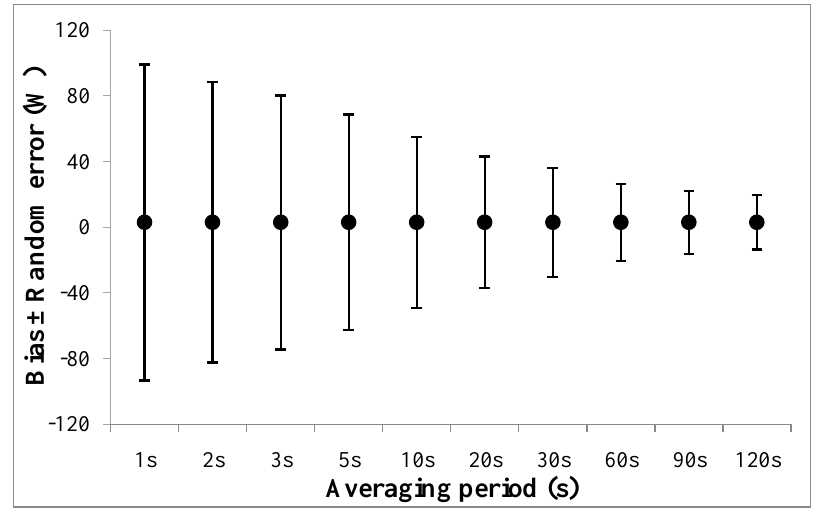
Figure 4. Bias ± random error of Stages power meter compared to SRM power meter during the 3 h field training session (personal data). Each point corresponds to a specific averaging period in order to analyze the same data samples.